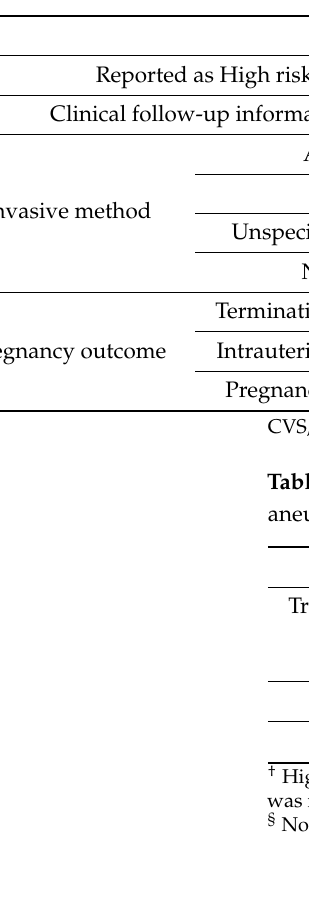
Figure 1. Detected chromosomal aberrations in the study population. Trisomy 21 was the most common trisomy detected, followed by trisomy 18. Concerning sex chromosomal aneuploidies (SCAs) and rare autosomal aneuploidies (RAA), XXY and trisomy 7 had the highest frequency. 3.3. Common Autosomal and Sex Chromosomal Aneuploidies Clinical follow-up information was available for 14 cases positive for trisomy 21, 8 cases positive for trisomy 18, 2 cases positive for trisomy 13, and 5 cases positive for SCA (2x XYY, 2x monosomy X, 1x XXY; Tables 3 and 4). Table 3. Clinical follow-up of positive NIPT results for common trisomies and sex chromosomal ane- uploidies.